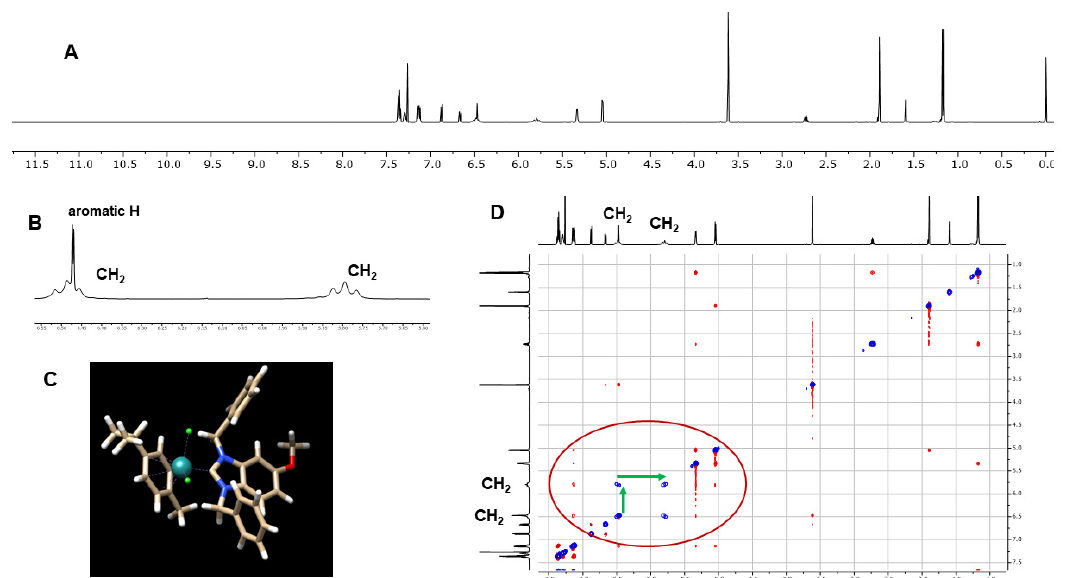
Figure 1. ( A ) 1 H-NMR spectrum (600 MHz, CDCl 3 ) of 3c ; ( B ) magnification of the section between 5.6 and 6.5 ppm; ( C ) DFT calculated geometry of 3c; ( D ) NOESY spectrum (600 MHz, CDCl 3 ) of 3c , the EXSY correlation peaks between the CH 2 hydrogens are marked with green